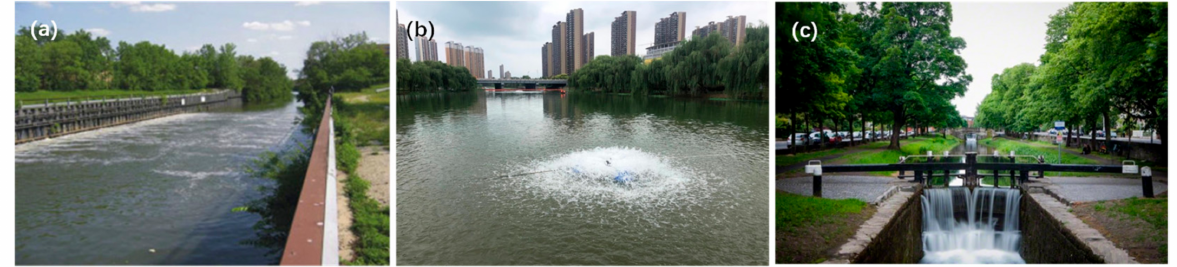
Figure 1. Aeration via river bubbling ( a ), pond water spreading ( b ), and canal waterfall ( c